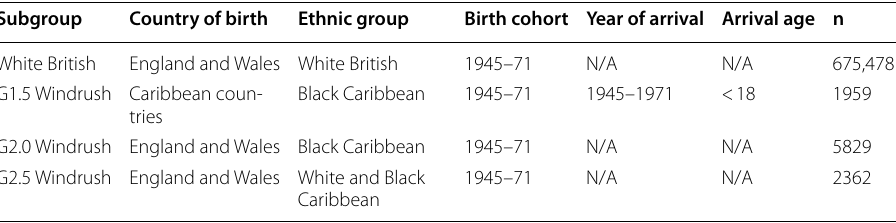
Table 1 Subpopulations of interest, identification criteria and total subpopulation sizes. Source : 5% microdata sample of resident population of England and Wales Subgroup Country of birth Ethnic group Birth cohort Year of arrival Arrival age n White British England and Wales White